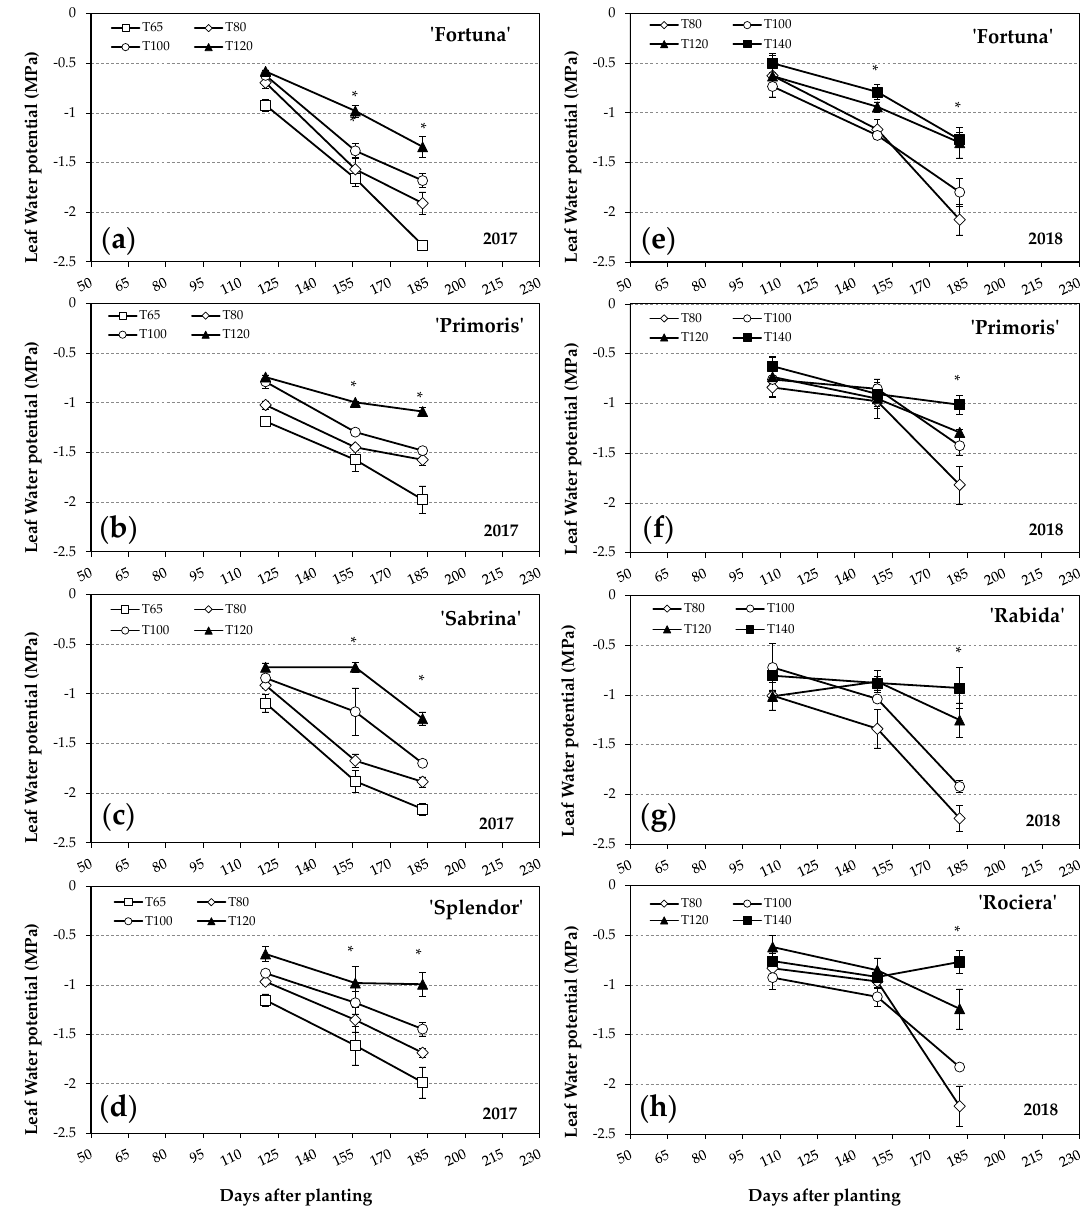
Figure 4. Leaf water potential measured at midday (1200–1400 h) in the study cultivars subjected to different water treatments (T65, T80, T100, T120 and T140) in the 2017 ( a – d ) and 2018 ( e – h ) cropping seasons. Each data point represents the mean ± SE ( n = 3). The asterisk indicates significant ( p < 0.05) differences between water treatments on each date.